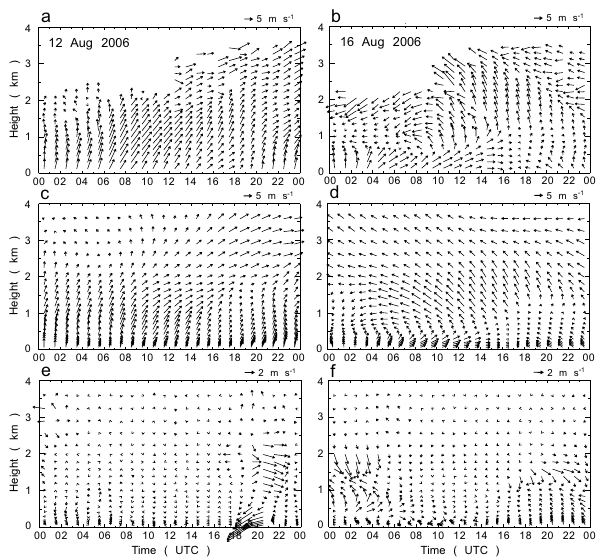
Fig. 10. Observed ( a and b ) and simulated wind profiles by the UCM ( c and d ) and the difference between the UCM simulation and the original LSM simulation ( f ) at the La Porte site on 12 August (left panels) and 16 August (right